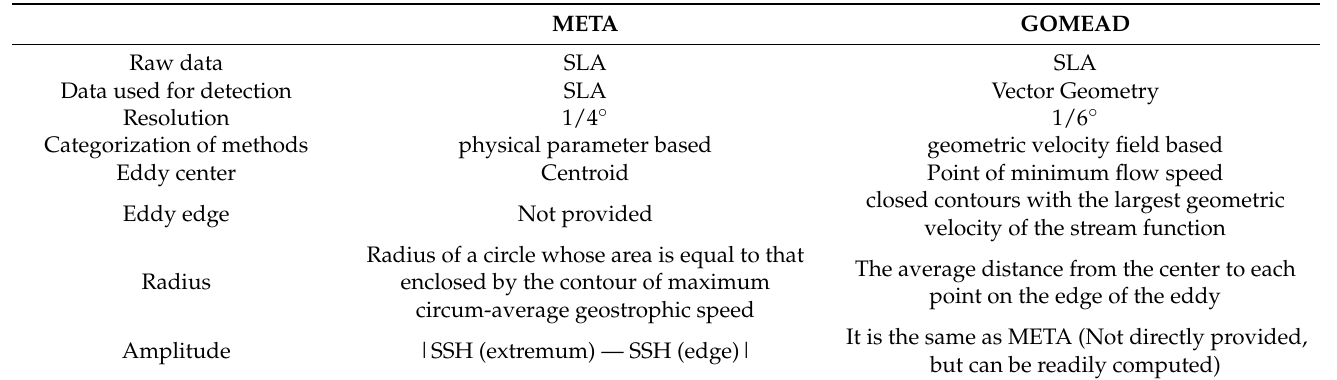
Table 1. Similarities and differences of the META and GOMEAD